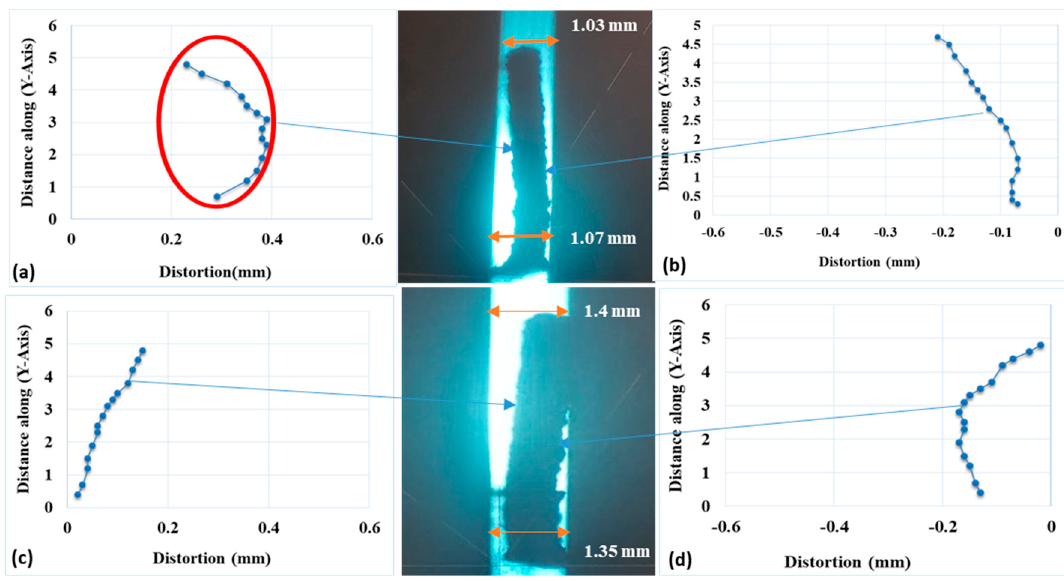
Figure 21. Distortion along the Y-axis for the 100-layers (all sides) for 5 mm height parts. ( a ) Left side from the front view. ( b ) Right side from the front view. ( c ) Left side from the bottom view. ( d ) Right side from the bottom view